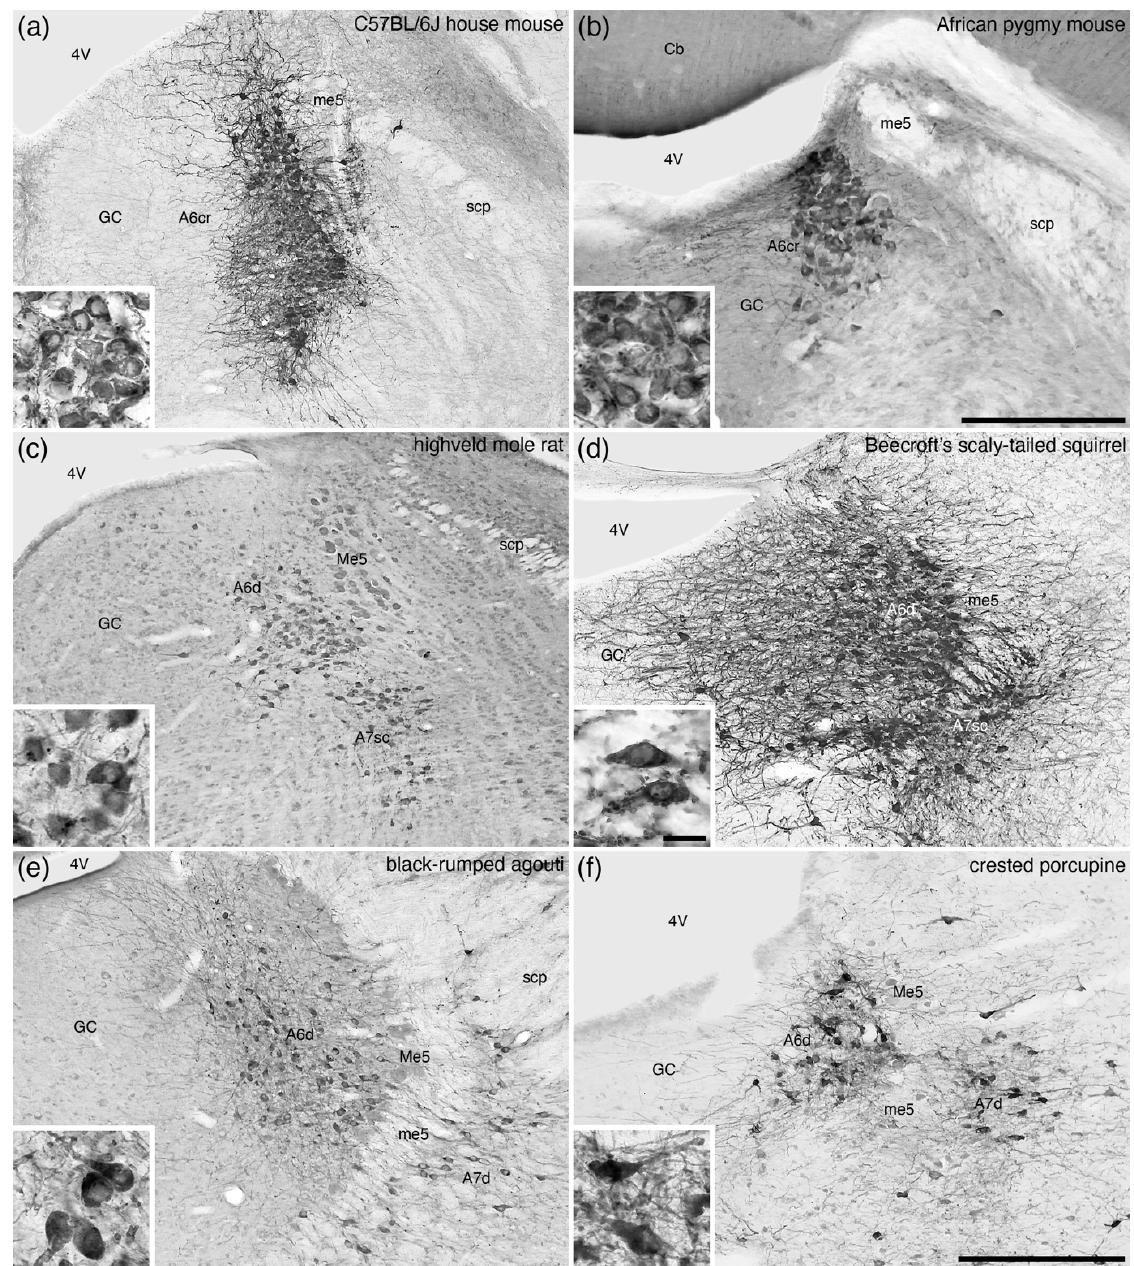
Figure 6. Low-magnification photomicrographs of the locus coeruleus ( A6 ), revealed with tyrosine hydroxylase immunostaining, in the brains of six species of rodents, ( a ) the C57BL/6J strain of house mouse ( Mus musculus ) [40,41], ( b ) the African pygmy mouse ( Mus minutoides ) [42], ( c ) the highveld mole-rat ( Cryptomys hottentotus ) [43], ( d ) Beecroft’s scaly-tailed squirrel ( Anomalurus beecrofti ) [44], ( e ) the black-rumped agouti ( Dasyprocta primnolopha ) [pers. obs.], and ( f ) the crested porcupine ( Hystrix africaeaustralis ) [45]. Note that in the two Murid rodents depicted, ( a , b ), the neurons forming the A6 are densely packed and extend dorsally to the floor of the fourth ventricle, forming what we term the compact portion of the locus coeruleus, rodent-type ( A6cr ). In contrast, the non-Murid rodents ( c – f ) evince an A6 nucleus that has less densely packed neurons, forming the diffuse portion of the locus coeruleus ( A6d ) as seen in most mammals. Insets show high-magnification images of the neurons from the A6 in each species. In all images, dorsal is to the top and medial to the left. Scale bar in ( b ) = 250 µm and applies to ( b ) only. Scale bar in ( f ) = 500 µm and applies to ( a , c – f ). Scale bar in inset ( d ) = 25 µm and applies to all insets. 4V —fourth ventricle; A7d —locus subcoeruleus, diffuse portion; A7sc —locus subcoeruleus, compact portion; GC —periventricular grey matter of the rostral hindbrain; Me5 —fifth mesencephalic nucleus; me5 –fifth mesencephalic tract; scp —superior cerebellar peduncle.